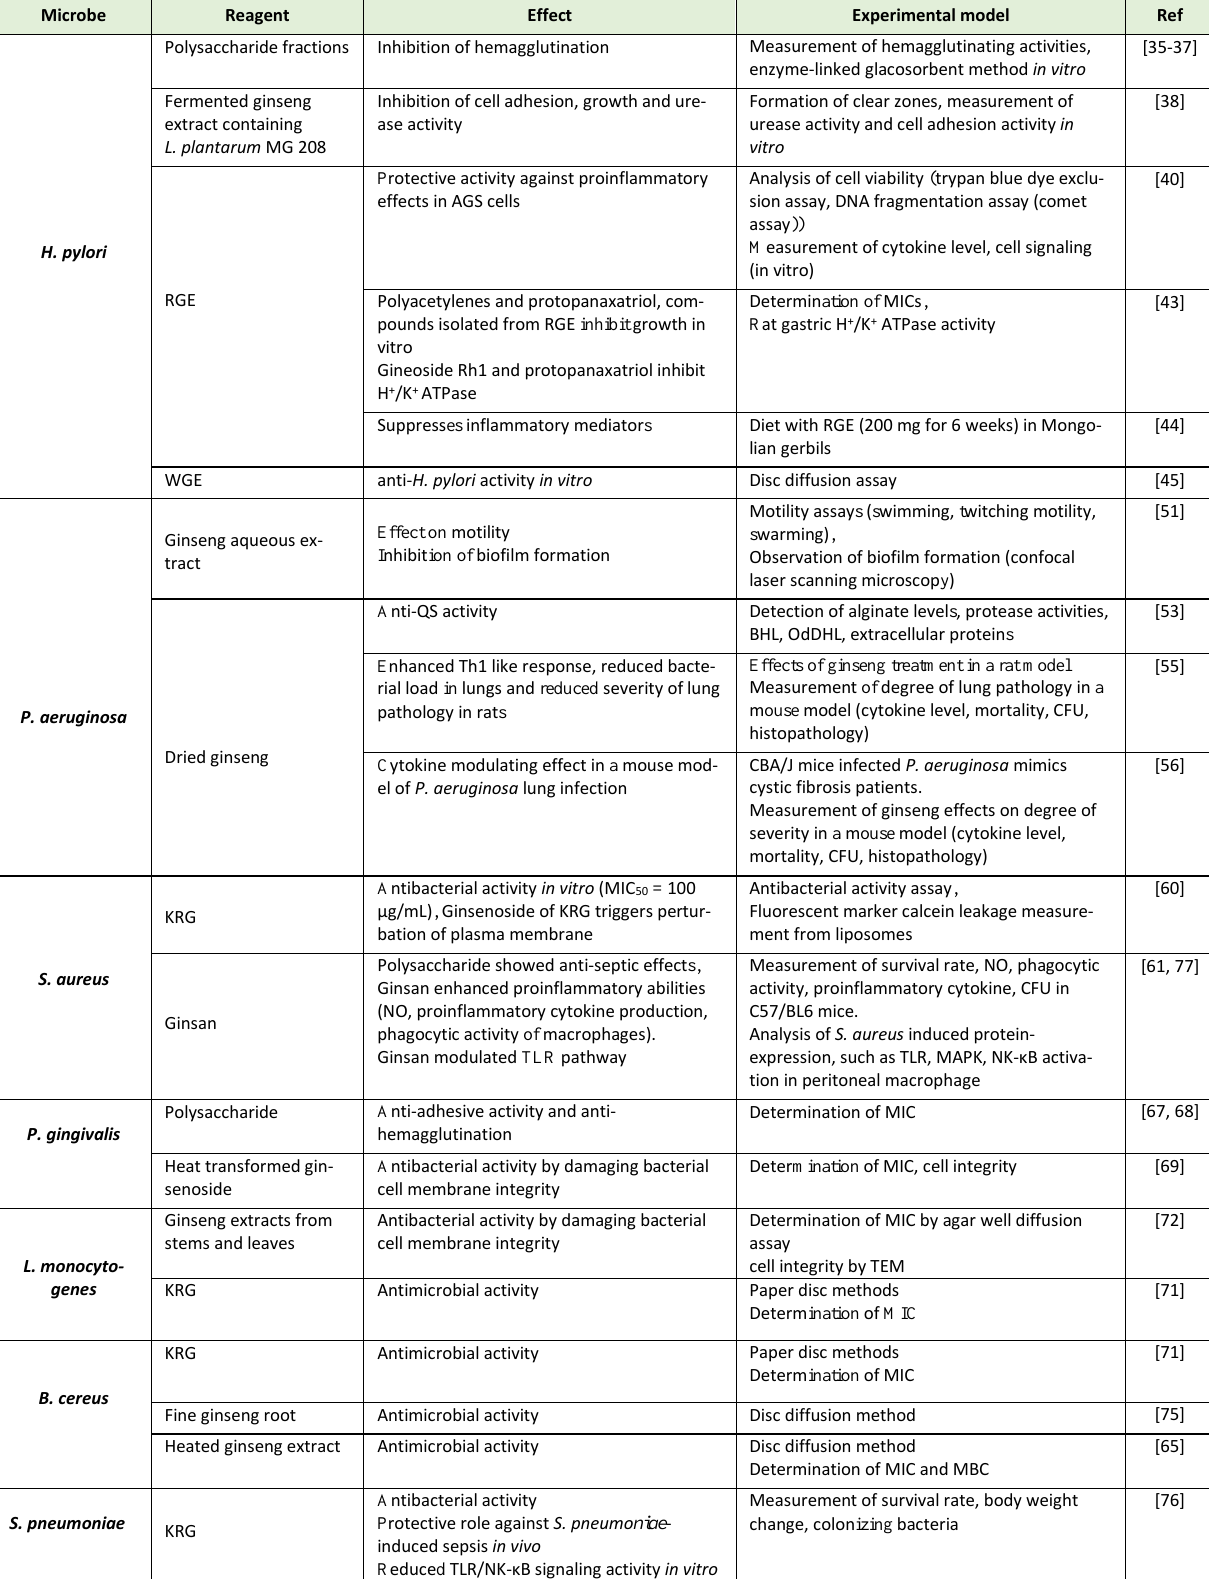
TABLE 1. Summary of the ginseng effects on bacterial infection.